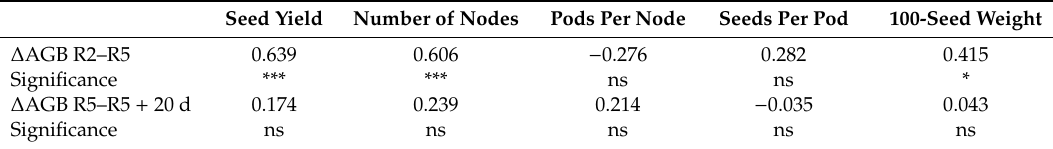
Table 5. Pearson’s coe ffi cients of correlation of the relationships between the increase in aboveground biomass ( ∆ AGB, g m − 2 ) and seed yield (g m − 2 ) and yield components (numbers of nodes per plant, pods per node, and seeds per pod, and 100-seed weight, g) during the reproductive stages (from R2 to R5 and from R5 to 20 days after R5) across three soybean cultivars and normal and late sowing dates in 2015 and 2016 ( n = 36) in the Tohoku region of northern Japan. Seed Yield Number of Nodes Pods Per Node Seeds Per Pod 100-Seed Weight ∆ AGB R2–R5 0.639 0.606 − 0.276 0.282